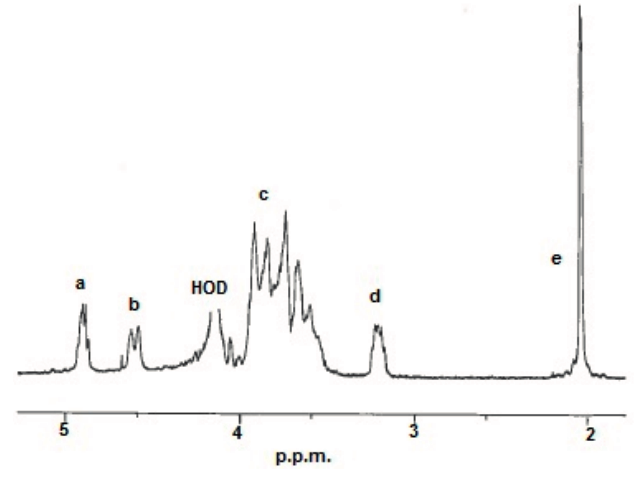
Figure 1. 1 H-NMR spectrum of a chitosan. Resonance: ( a ) H-1 in D-units; ( b ) H-1 in A-units; ( c ) H-2/6 in A-units and H-3/6 in D-units; ( d ) H-2 in D-units and ( e ) 3H from the acetyl group. HOD =